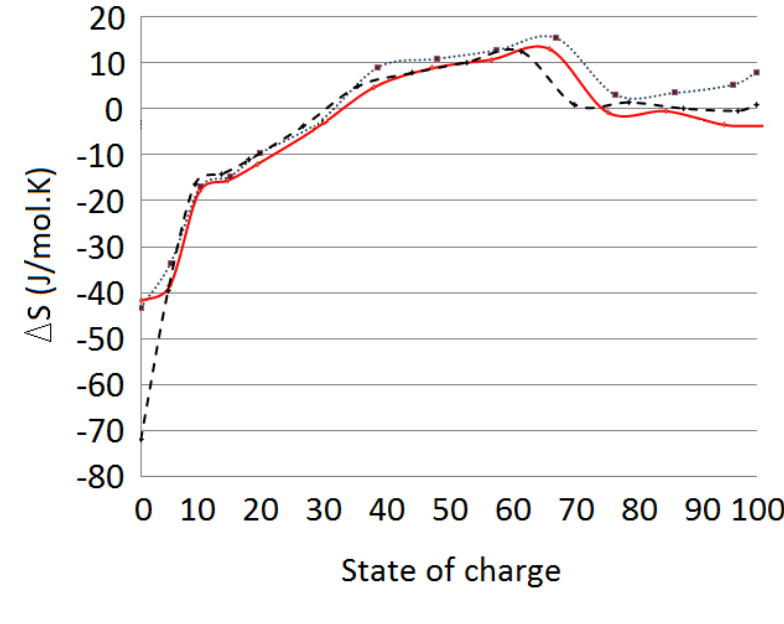
pouch cell (dotted line), a 40-A·h LiNiCoO 4 O cell (dashed 2 4